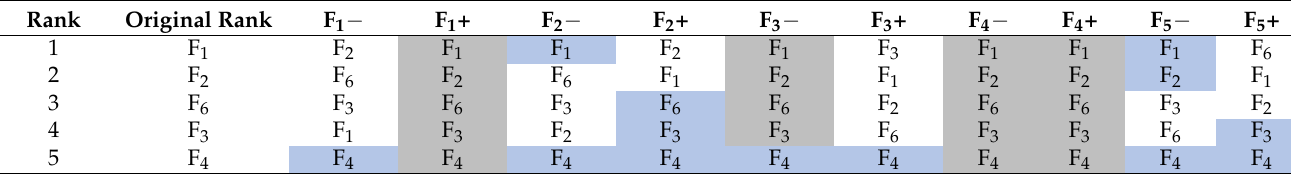
Table 22. Sensitivity analysis results for the alternatives—the factors’